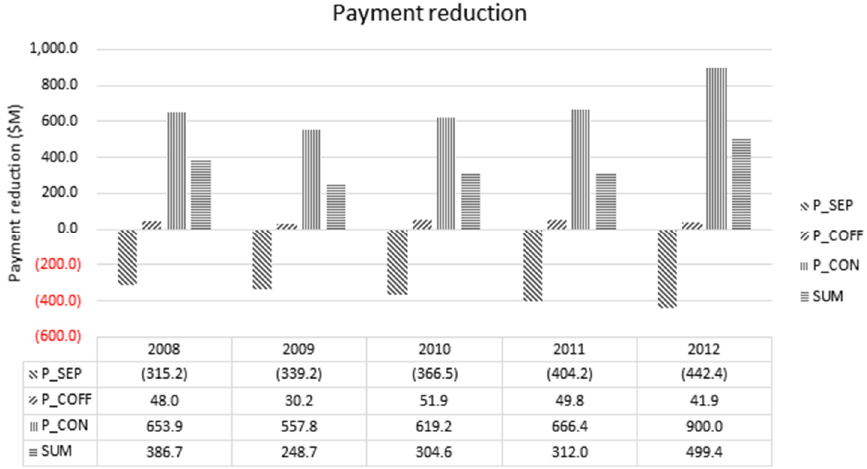
Figure 6. Estimated payment reduction (ESS capacity = 500 MW).